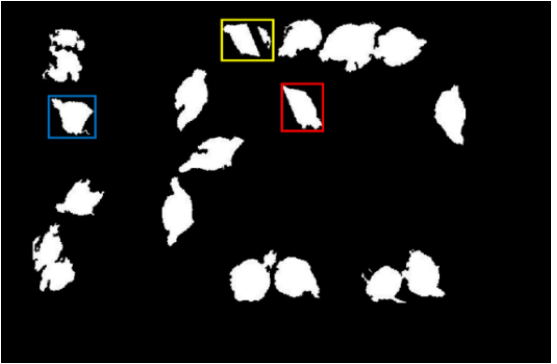
Figure 4. The result of equipment area removal. The area loss of the broiler chicken in the blue, yellow, and red boxes were caused by the feeder, water pipe, and water pressure regular, respectively.